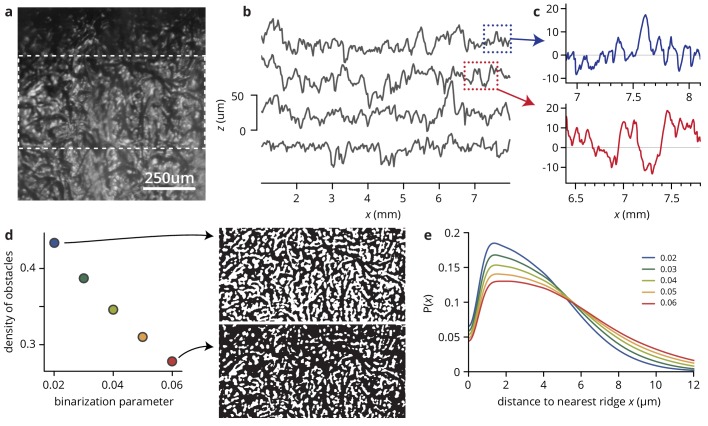
Analysis of substrate roughness.(a) Microscopic image of an agar surface patterned with filter paper as described in Materials and methods. The image was created by stitching together six images taken on a Dektak 150 profilometer under oblique illumation. Light areas correspond to elevations, dark areas to troughs. (b) Traces along the vertical direction in panel (a), shifted for visibility (see Materials and methods). The mean roughness is 10 ± 1 μm, with a range of elevations to troughs of 50 μm. (c) Close-up of longer runs in (b). (d) Estimating the density of 'obstacles’, that is parts of the patterns that are significantly elevated compared to their surroundings. The images are binarized version of the area between the dashed lines in (a), using the LocalAdaptativeBinarize function in Mathematica with at 15 pixel radius; pixels are scored as one if they are brighter than 0.8×μ+0.05×σ+ϵ, where μ and σ are the local mean and standard deviation in intensity, and ϵ is an intensity shift. The dependence of the proportion of pixels scored as one on ϵ is shown in the plot in (d). (e) For different values of ϵ, histograms of the distances x of dark pixels from the nearest white pixel, showing that the width of 'valleys’, i.e., the distance between adjacent ridges, is limited to ≤25 μm (twice the range of x).10.7554/eLife.44359.007Figure 1—figure supplement 2—source data 1.Source data for Figure 1—figure supplement 2 (Five stylus runs to measure substrate roughness).